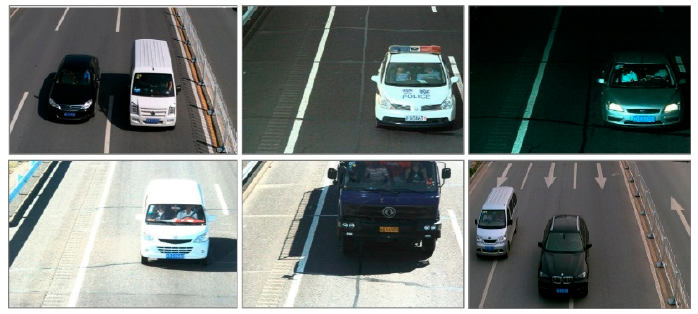
Figure 4. Some images in BIT-Vehicle dataset.